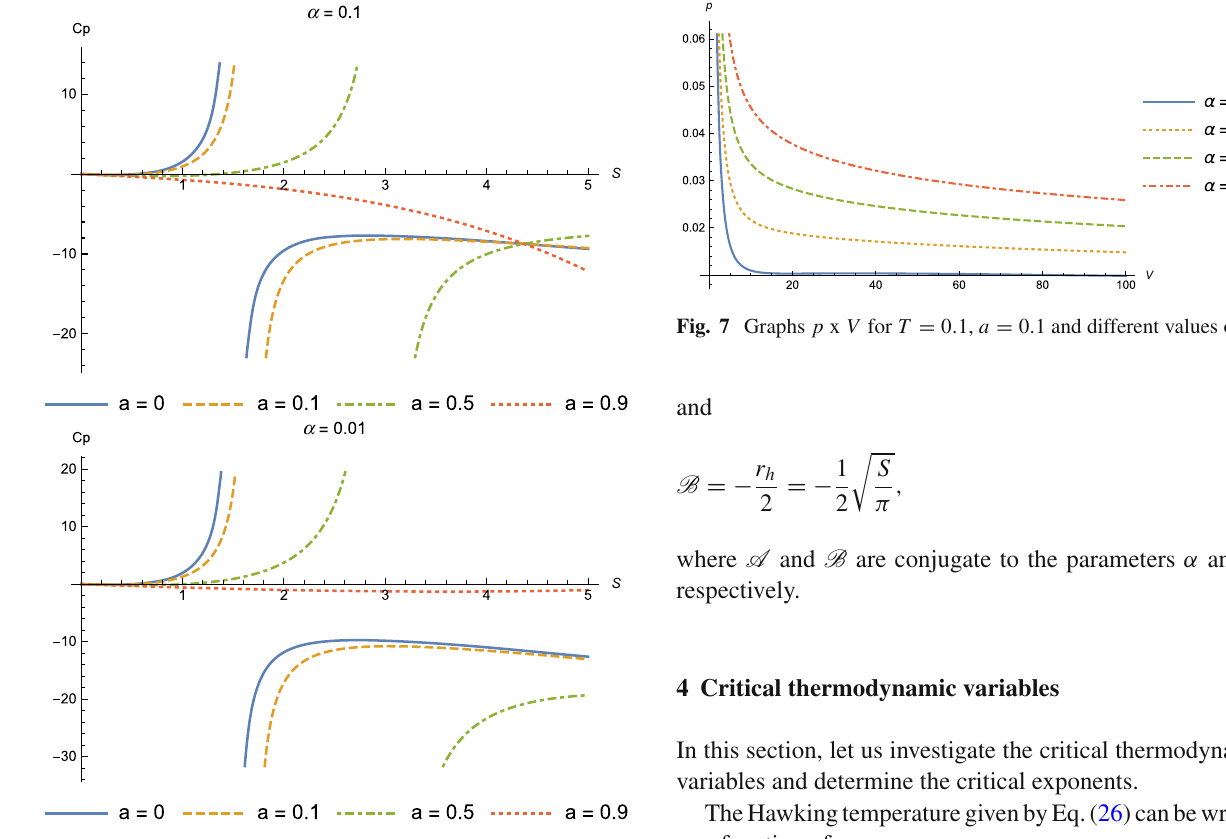
Fig. 4 The heat capacity at constant pressure, C p , as a function of the entropy, S